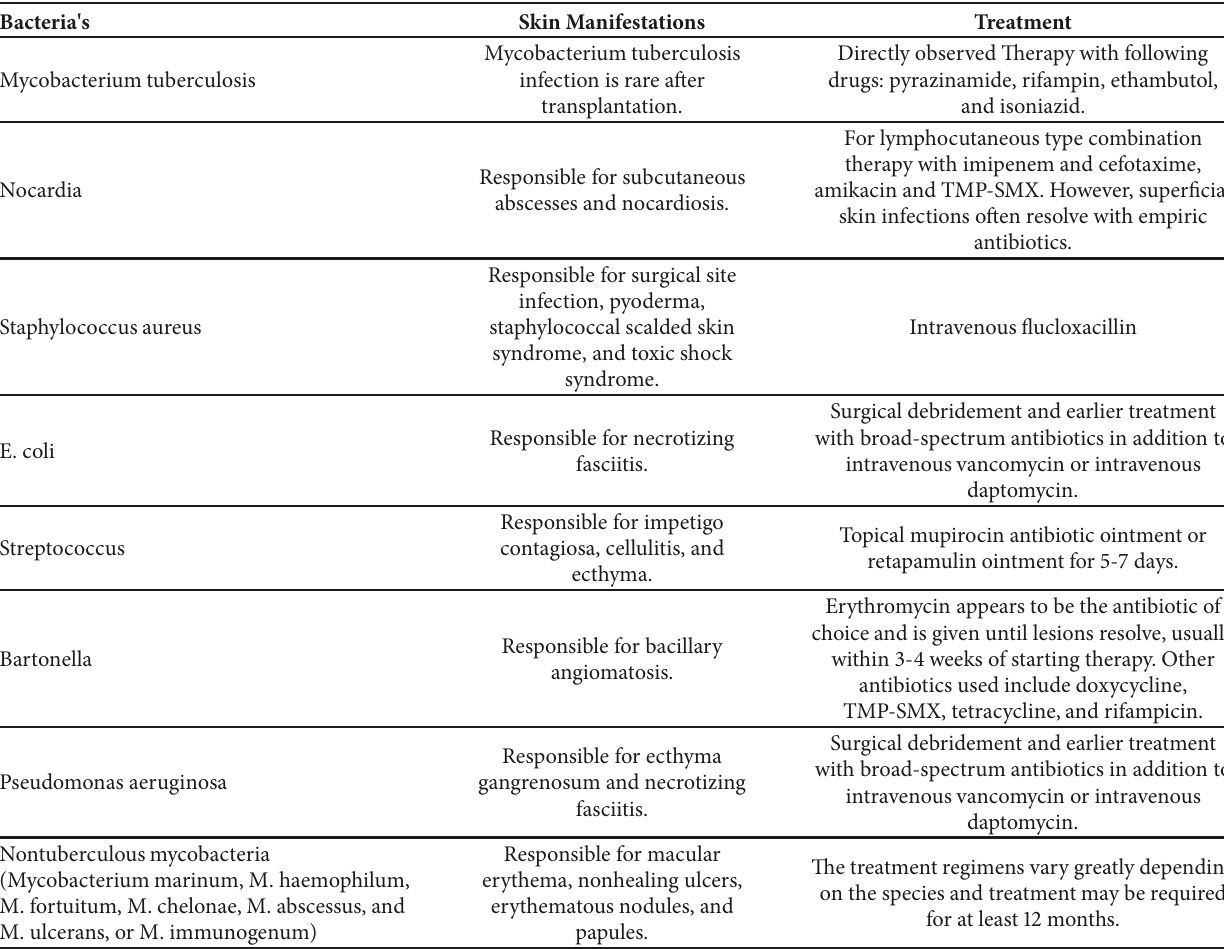
Table 3: Bacterial skin infection after liver